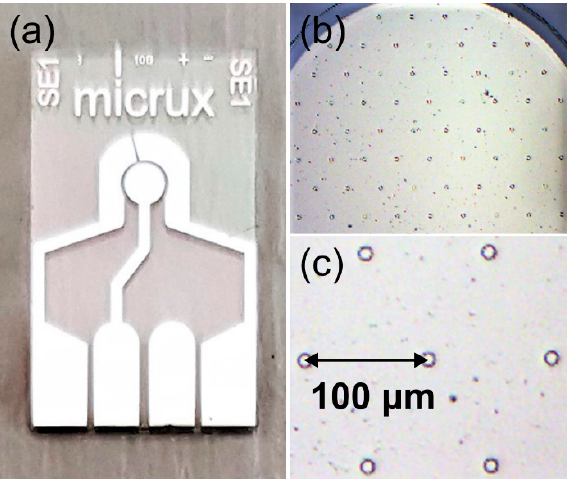
Figure 2. ( a ) Photo of a platinum MicruX microarray thin-film electrode, ( b ) optical microscope image of the microarray working electrode defined across an SU-8 overlayer, and ( c ) further zoomed-in optical microscope image showing the pitch distance between two µ-holes.